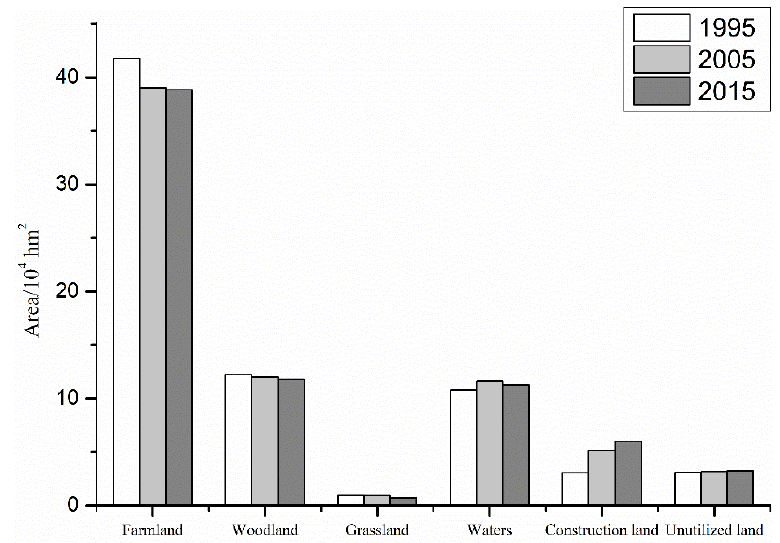
Figure 3. Land ‐ use area of the first classes in 1995, 2005, and 2015.